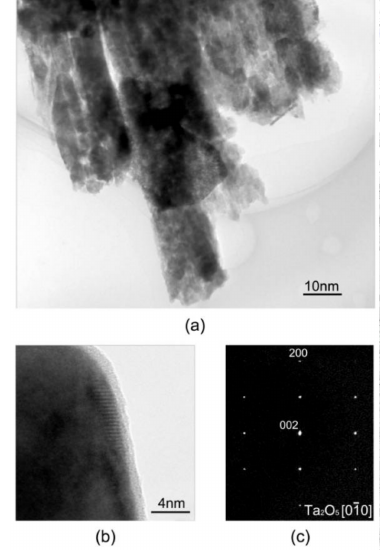
Figure 3. TEM image and high resolution TEM image of nanotube(s) ( a , b ); the SADPs taken from the orthorhombic Ta 2 O 5 phase ( c ) (the zone axis indices are